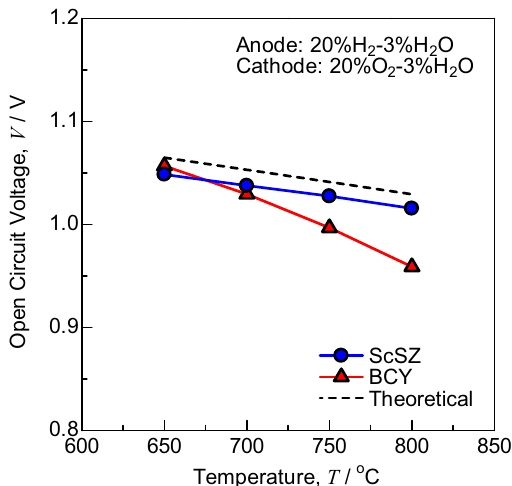
Figure 1. Temperature dependence of OCVs in H 2 :H 2 O:N 2 = 20:3:77 vol.% (anode) and O 2 :H 2 O:N 2 = 20:3:77 vol.% (cathode) for SOFCs supported on ScSZ electrolyte and PCFCs supported on BCY electrolyte. The dotted line indicates the theoretical EMF, when the transport number is assumed to be unity.